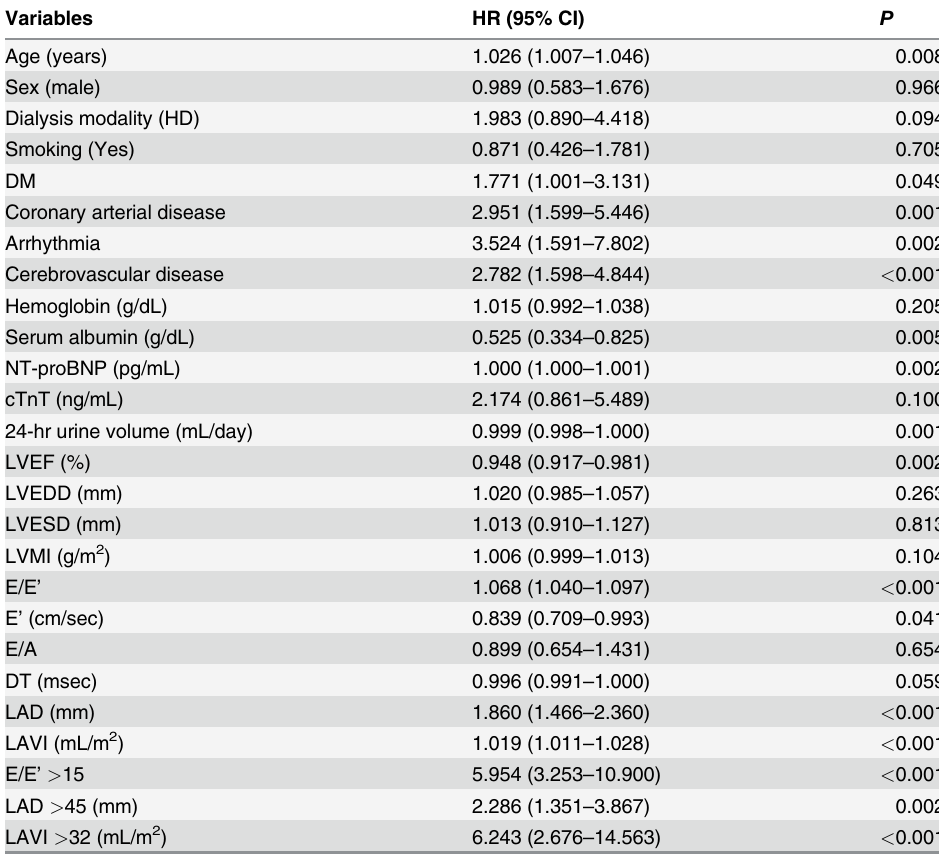
Table 6. Univariate Cox proportional hazards regression analysis for CV